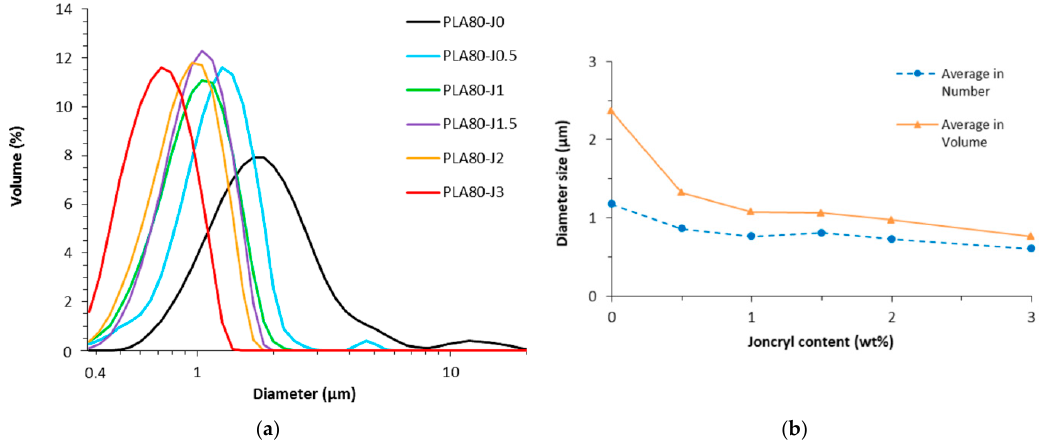
Figure 3. Size distribution curves ( a ) and emulsification curve ( b ) of PA11 dispersed phases diameter as a function of Joncryl content. as a function of Joncryl